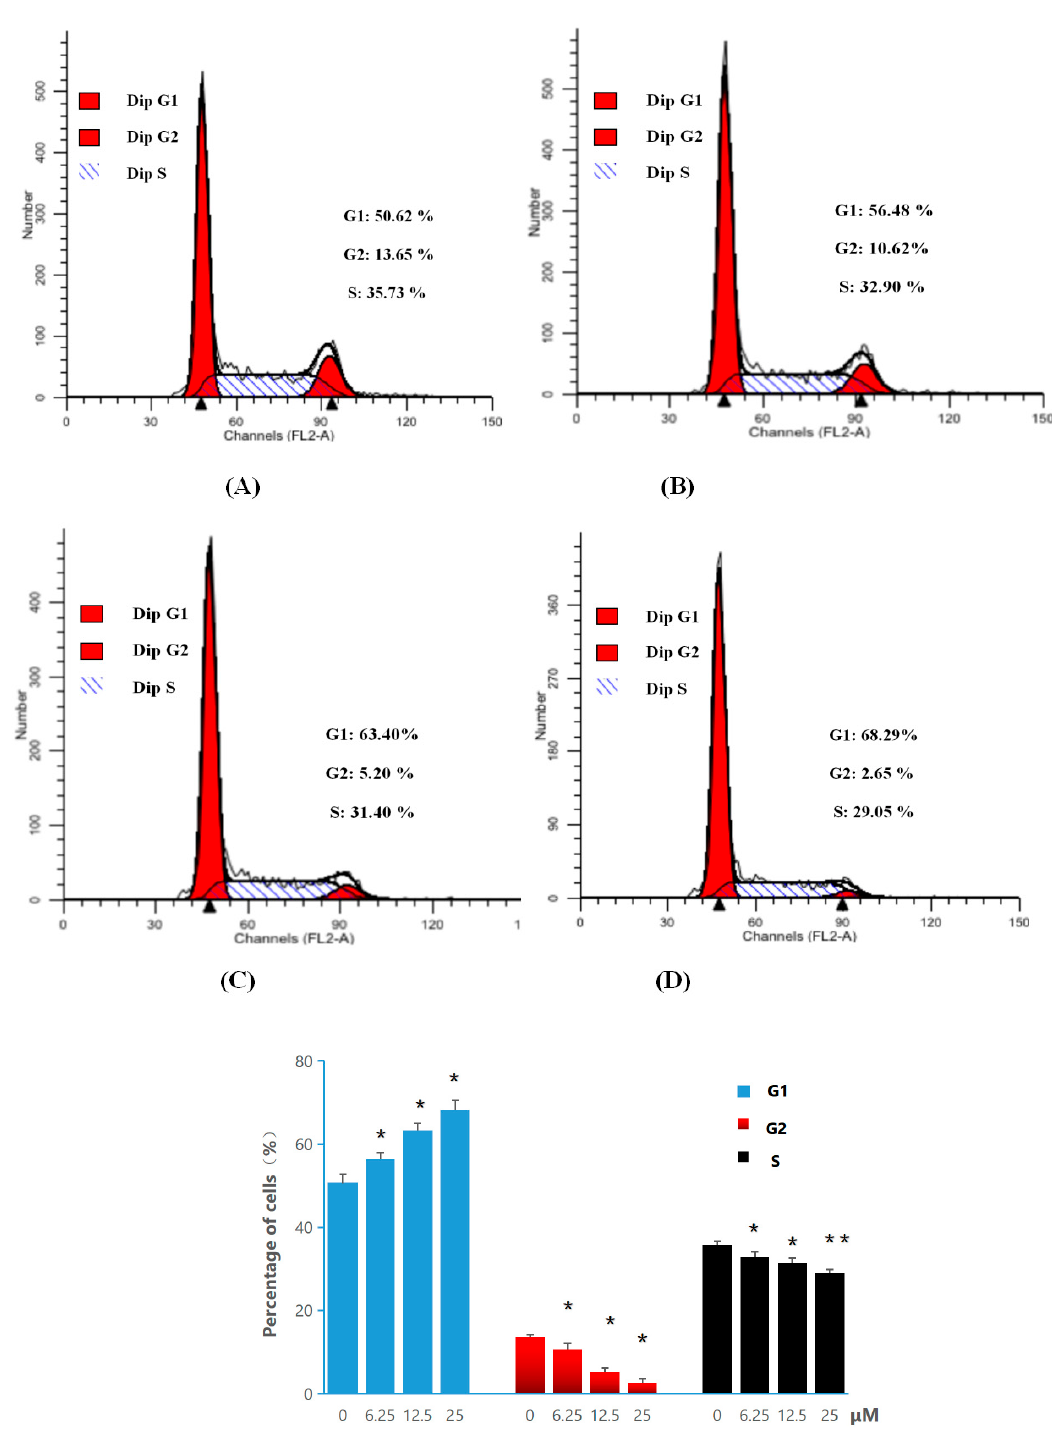
Figure 10. Cell-cycle analysis of HL-60 cells treated with compound 2i for 48 h, by flow cytometry. ( A ) Not treated with compound 2i (control); ( B ) treated with compound 2i at 6.25 µ M; ( C ) treated with compound 2i at 12.50 µ M; ( D ) treated with compound 2i at 25 µ M; ( E ) The percentages of each population are shown as mean ± SD. Data shown in the figure are representative of three independent experiments (* p < 0.05, ** p <